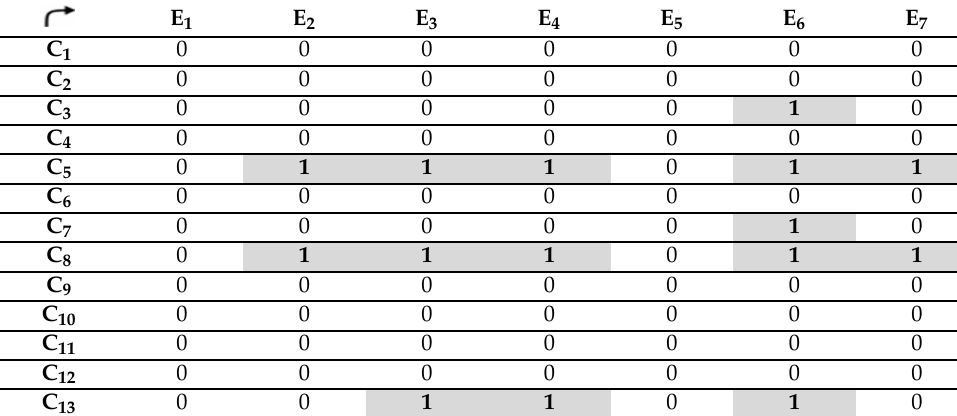
Table 11. Forgotten effects matrix [ (cid:101) O ]